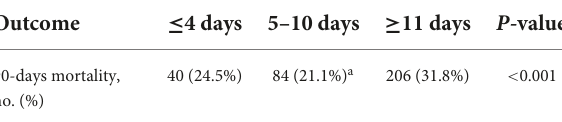
TABLE 2 Primary outcome of patients at different tracheostomy timing.